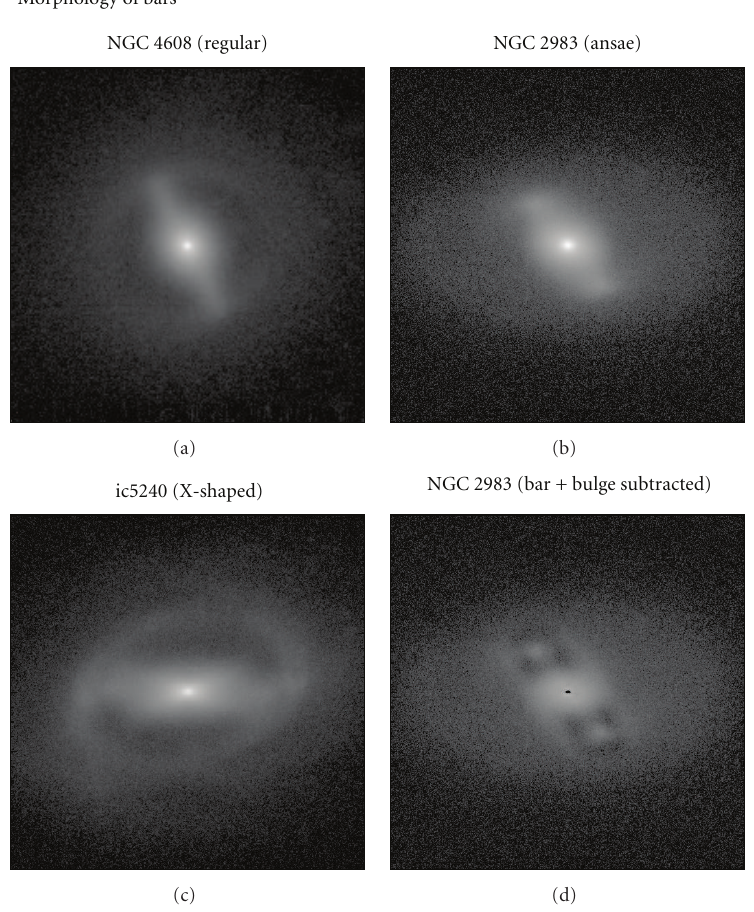
Figure 2: This figure is compiled of two figures that originally appeared in Laurikainen et al. [25]. The images are flux calibrated and are shown in a logarithmic scale, covering the full magnitude range of the images. The original images are shown, except in d) where the bar and bulge models from the decomposition are subtracted from the original image of NGC 2983. These images highlight the main bar morphological types in S0